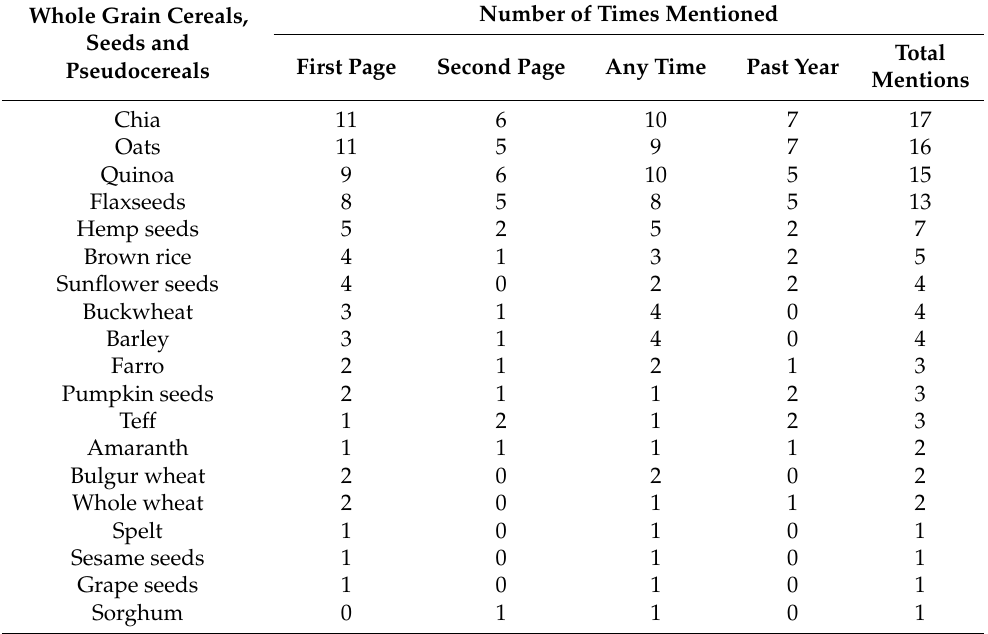
Table 5. Classification of whole grain cereals, seeds and pseudocereals by the number of times that were mentioned on selected web